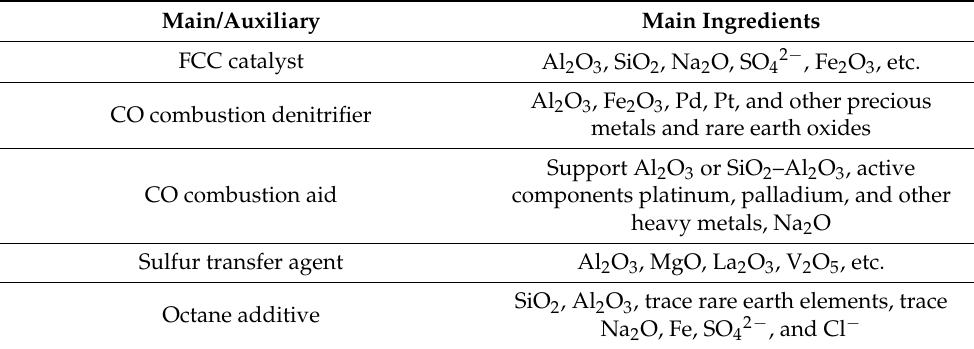
Table 3. Main/co-catalyst characteristic